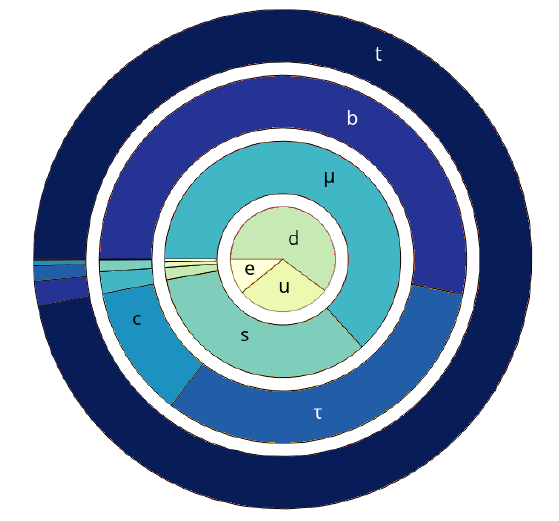
Figure 1 . This set of sector charts illustrates the hierarchy among the set of charged fermion masses, f m t ; m b ; m (cid:28) ; m c ; m (cid:22) ; m s ; m d ; m u ; m e g . Each mass has its own color, the darker the color the heavier the mass. The outer ring shows how m t (cid:29) f m f g ( f 6 = t ). The following one has the same set of masses without its largest previous contribution, i.e. the top quark mass. Here the fermions in the set f m b ; m (cid:28) ; m c g are of similar mass while the other fermions are much lighter. The same logic continues with the other two smaller rings. The major contributions to each ring imply four di(cid:11)erent groups: f m t g , f m b ; m (cid:28) ; m c g , f m (cid:22) ; m s g , and f m d ; m u ; m e g , illustrating a similar scale, 174 GeV, 1 GeV, 0 : 1 GeV, and 0 : 001 GeV, for each group, respectively. If neutrinos were